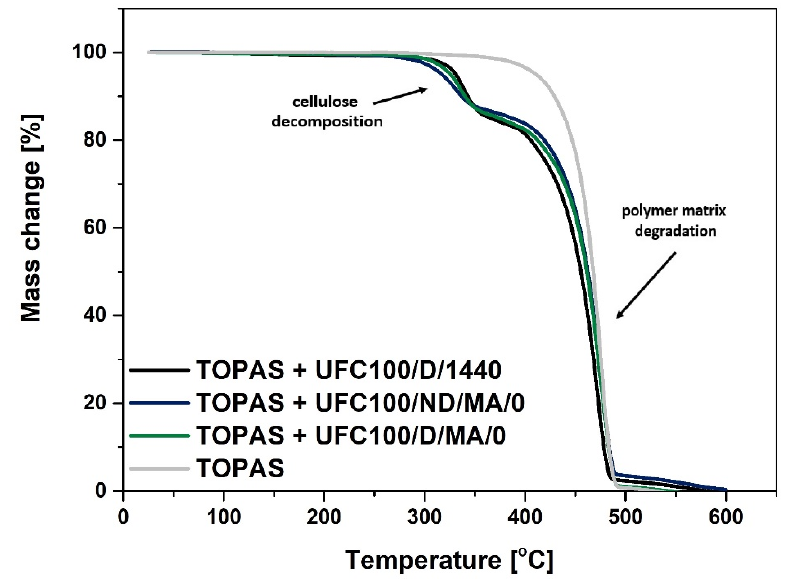
Figure 2. TGA curves of analyzed blend samples filled with MA treated cellulose fibers (regular chemical modification approach) dried either not dried before the carried out process; UFC100 / D / 1440—cellulose fibers dried for 1440 min (24 h) at 100 ◦